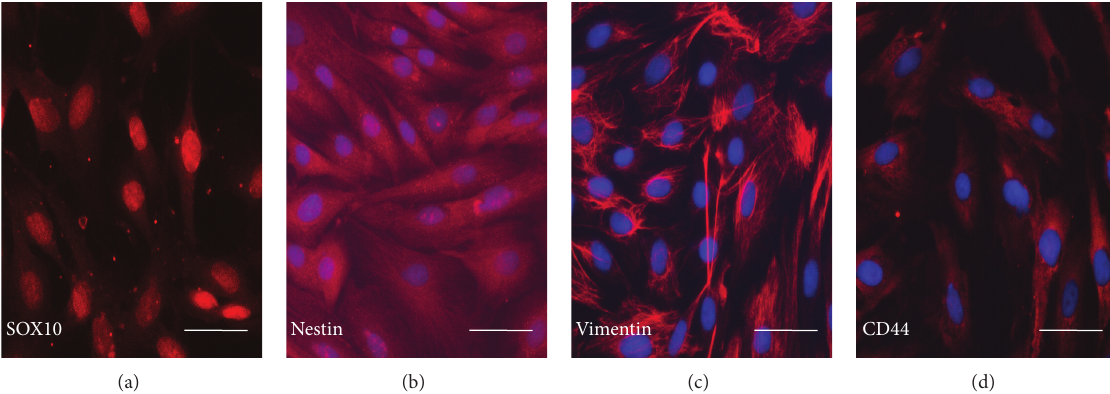
Figure 2: Labeling of neural crest cell markers on REMSCs: those markers were positively stained for SOX10 (a), nestin (b), vimentin (c), and CD44 (d). Nuclei were labeled with Hoechst 33342 (blue) except for SOX10. Bar: 20 𝜇 m for all pictures.